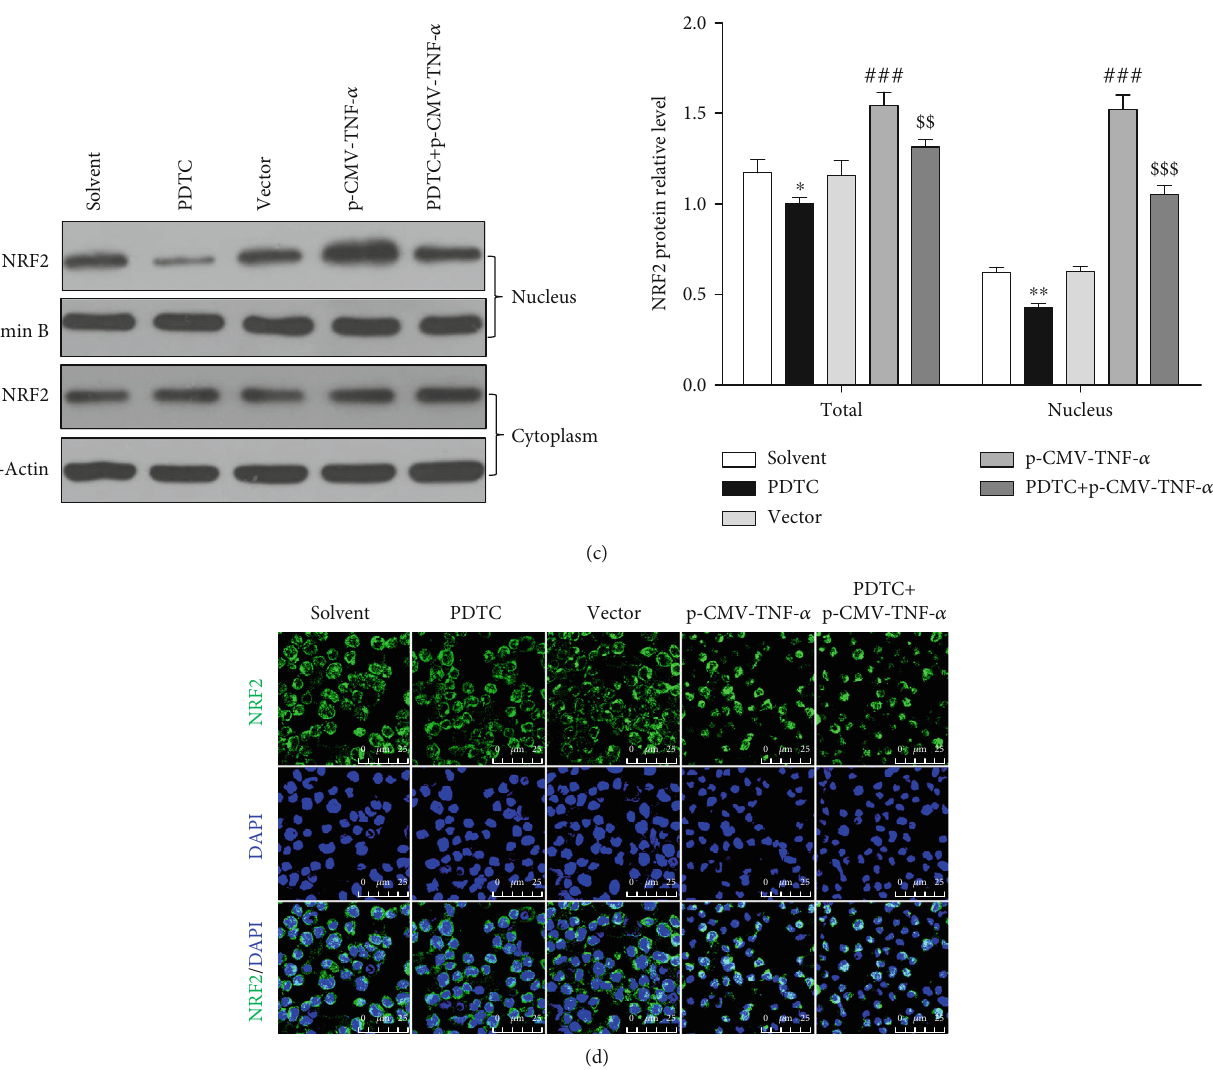
Figure 6: LPS-induced NRF2 expression and nuclear abundance of NRF2 depended on TNF- α . Control and TNF- α overexpression (p- CMV- TNF- α ) gEECs were exposed to 50 μ mol/L PDTC and 8 μ g/mL LPS for 12 hours. (a) RT-qPCR analysis was used to detect the expression of TNF- α mRNA. Data shown are mean ± SD , ns was P > 0 : 05 , and ∗∗∗ was P < 0 : 001 vs. solvent group. P value was calculated by the one-way ANOVA with Tukey ’ s test as a posthoc test. (b) Immunoblotting was used to detect the expression of TNF- α and (c) NRF2 expression, and we harvested nuclear and cytoplasmic total proteins separately to detect the expression of NRF2 protein; so, the sum of NRF2 expression in nucleus and cytoplasm is the expression level in total cells. Data shown are mean ± SD , ∗ was P < 0 : 05 , and ∗∗ was P < 0 : 01 vs. solvent group, ### was P < 0 : 001 vs. vector group, $$ was P < 0 : 01 , and $$$ was P < 0 : 001 vs. p-CMV- TNF- α group. P value was calculated by Student ’ s t -test. (d) The dynamic changes of cytoplasmic and nuclear NRF2 were imaged by immuno fl uorensent staining. Scale bar was 45 μ